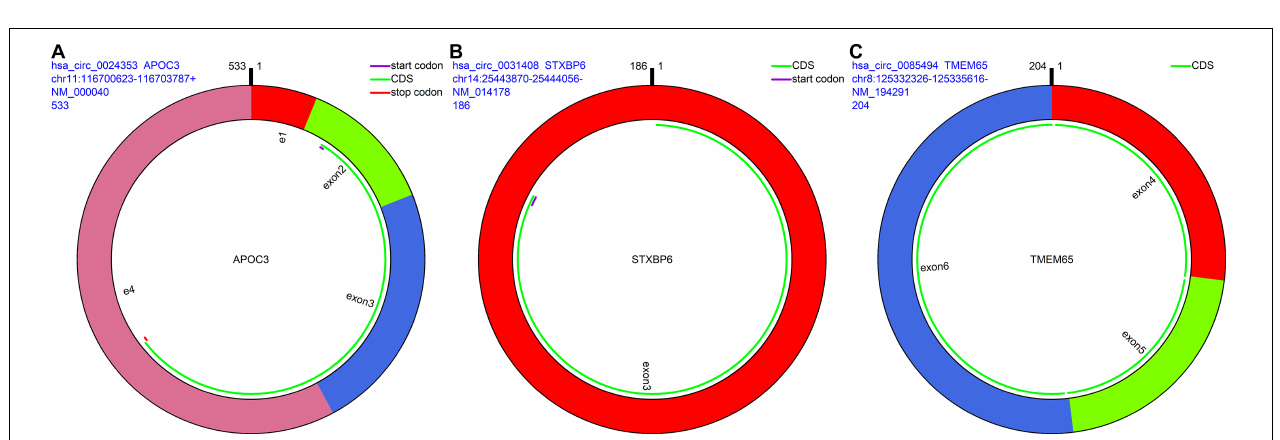
FIGURE 2 | Heatmap of selected circRNAs. A total of five circRNAs were selected from four prostate cancer samples and four normal adjacent prostatic tissues samples. Red represents upregulation and green represents downregulation.